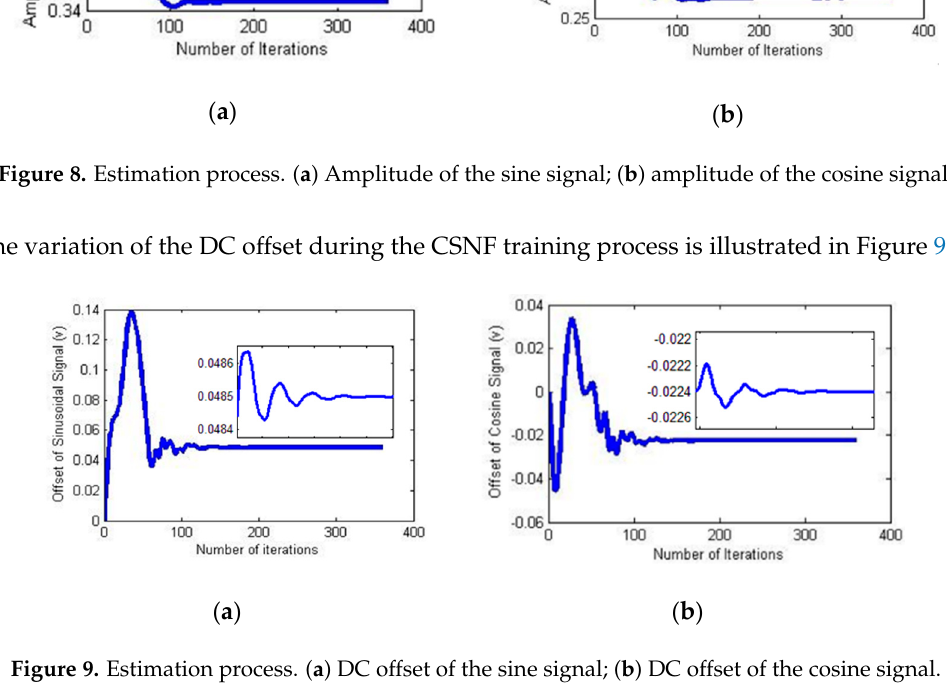
The changes in the phase shift and loss values during the training process are shown in Figure 10.